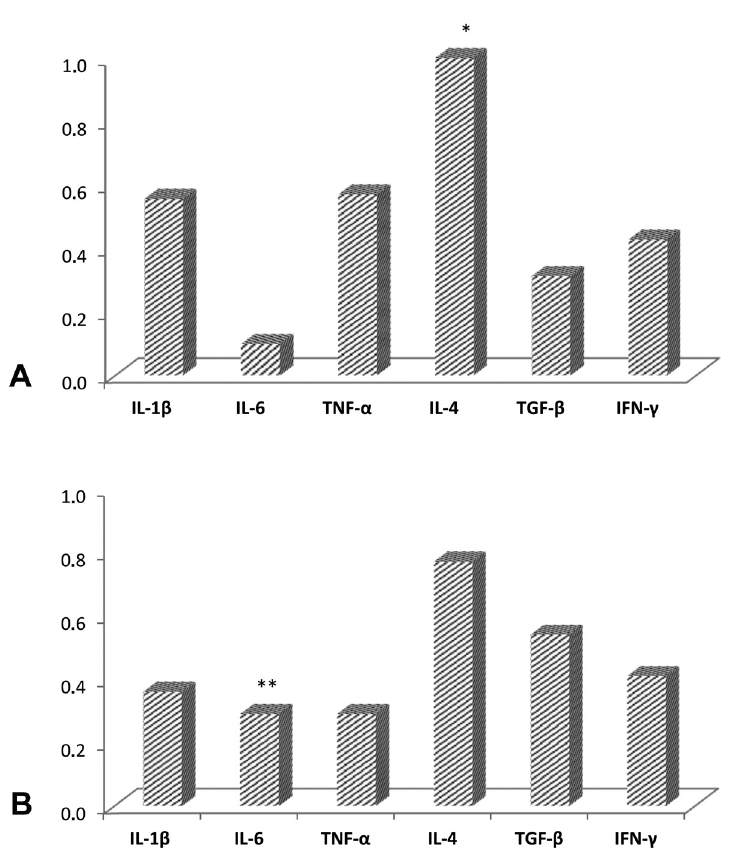
Figure 2- Multiple comparisons between pro-inflammatory and anti-inflammatory cytokines in apical periodontitis lesions. A, granuloma (* p<0.008: IL-4 x IL-6 and IL-4 x TNF- α ); B, cyst (** p<0.008: IL-6 x IL-4 and IL-6 x IFN-γ). Wilcoxon multiple comparisons test with Bonferroni correction to p<0.008